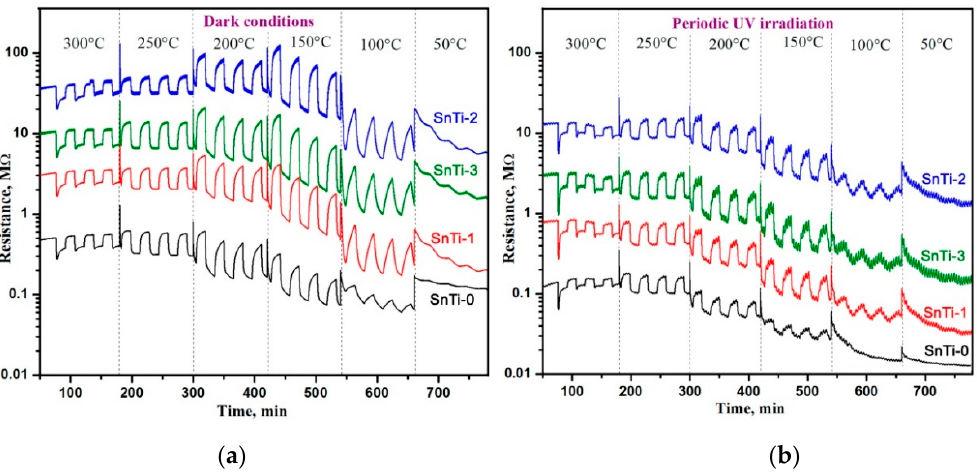
Figure 6. Resistance of the TiO 2 @SnO 2 nanocomposites in the temperature range 300–50 °C under periodic change of the gas phase composition ( a ) in dark conditions; ( b ) under periodic UV ( λ max = 365 nm) illumination.